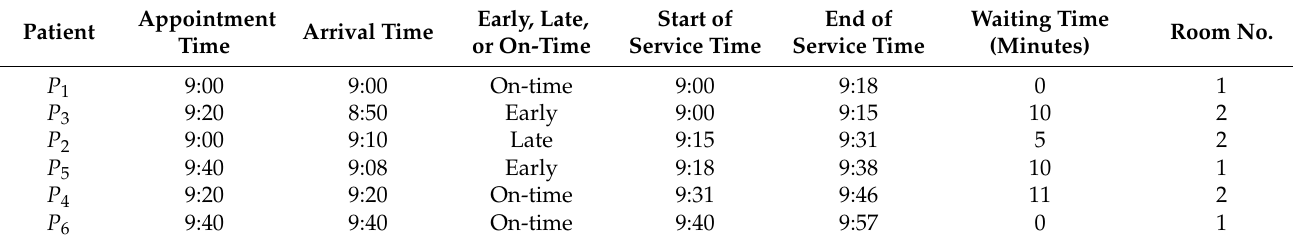
Table 11. Preempt policy with variable service